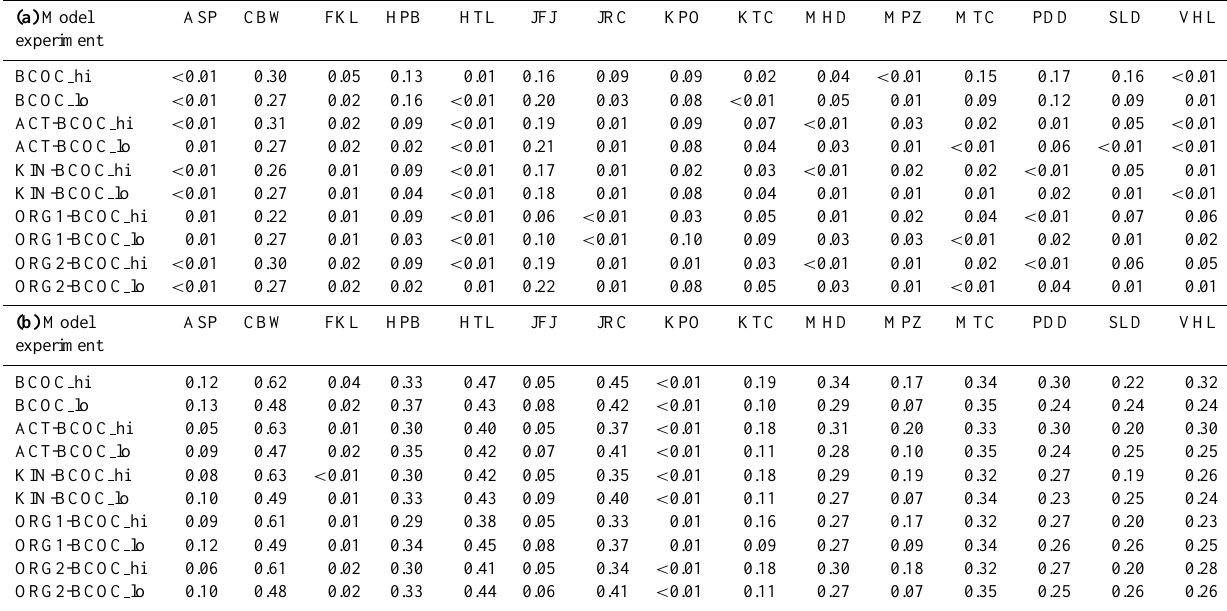
Table 6. Correlation coefficient ( R 2 ) between observed and simulated hourly mean particle number concentrations (a) D p > 15nm and (b) D p > 100nm at each ground site. Ground site acronyms are given in Table